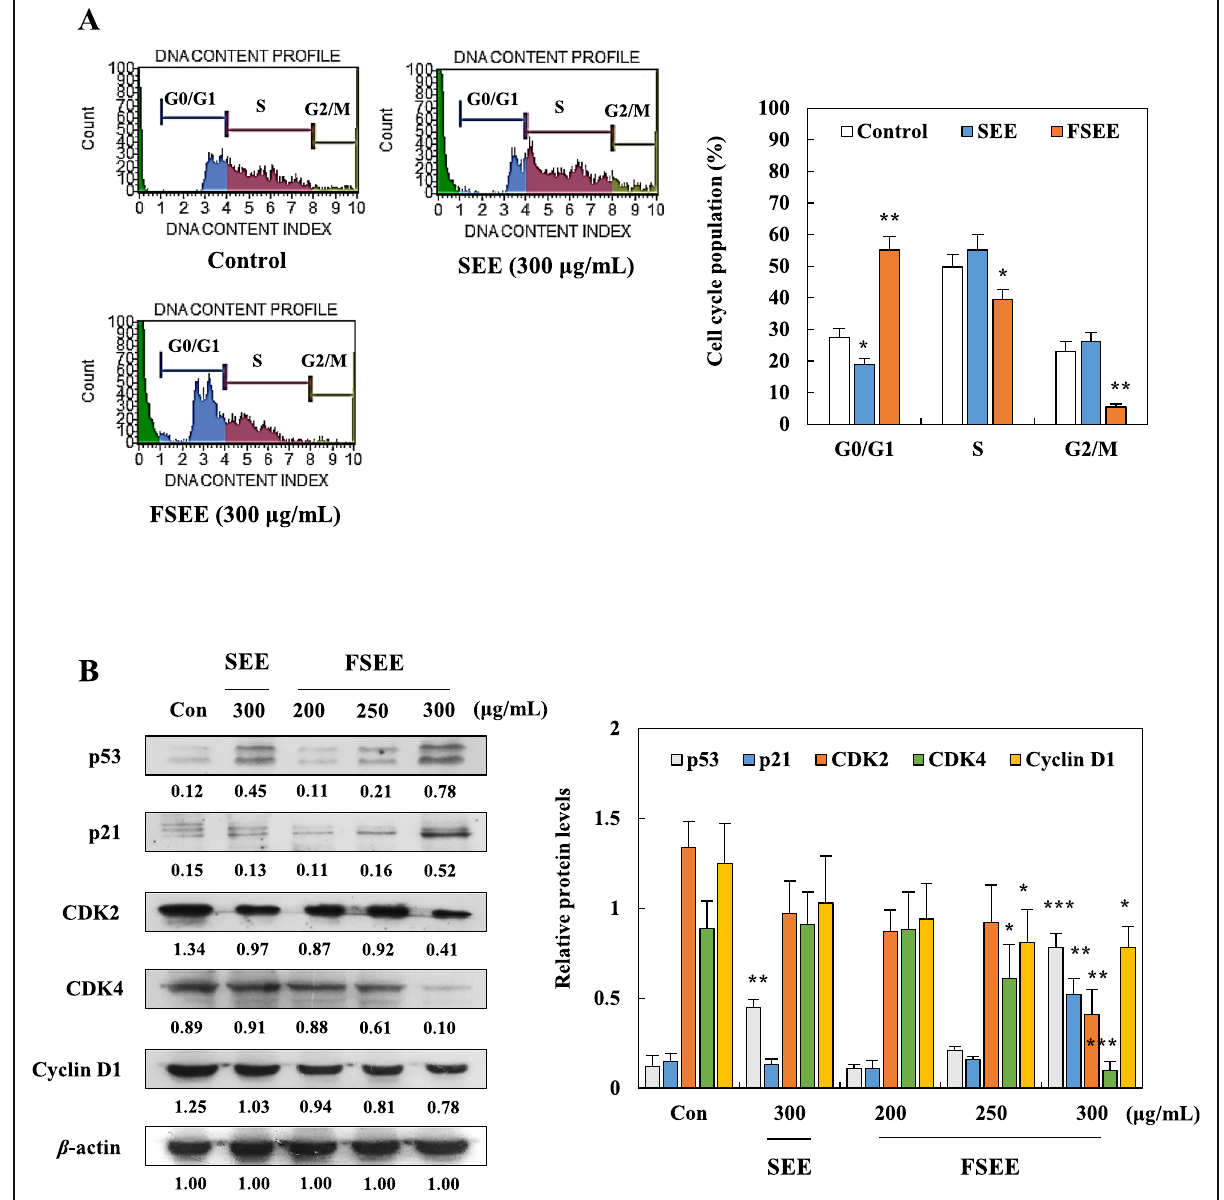
Fig. 2 Effect of SEE, and FSEE on G0/G1 cell cycle arrest in HepG2 hepatocellular carcinoma cells. Cells were treated with SEE, and FSEE for 24 h. a Cell cycle population was analyzed by flow cytometry. b After 24h, total cell lysates were subjected to detect expression of cell cycle arrest-related proteins in HepG2 cells. Data values were expressed as mean±SD of triplicate determinations. Significant differences were compared with control at * p <0.05, ** p <0.01, and *** p <0.001 using one-way (Fig. 3c) when compared to non-treated and SEE-treated cells. These data show that FSEE induced apoptotic cell death in HepG2 human hepatocellular carcinoma cells.